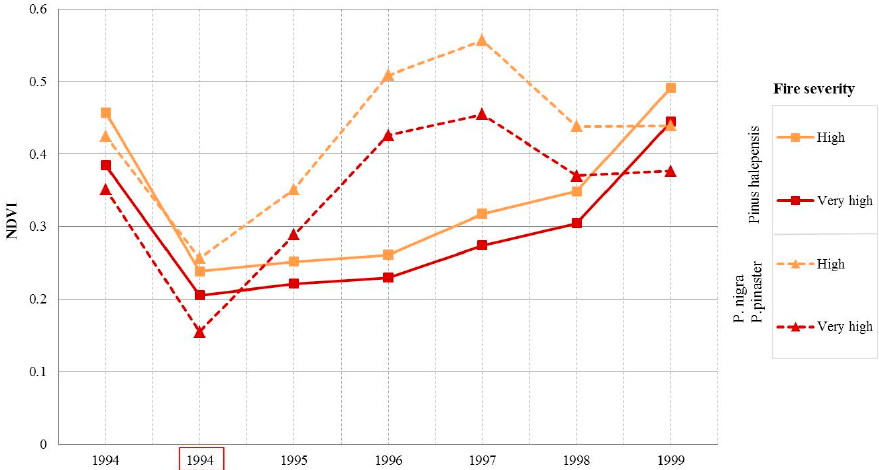
Figure 3. Short-term regeneration of Pinus species according to fire severity levels: >2.5 to <2.85 = High; >2.85 to 3 = Very High. NDVI: Normalized Difference Vegetation Index .